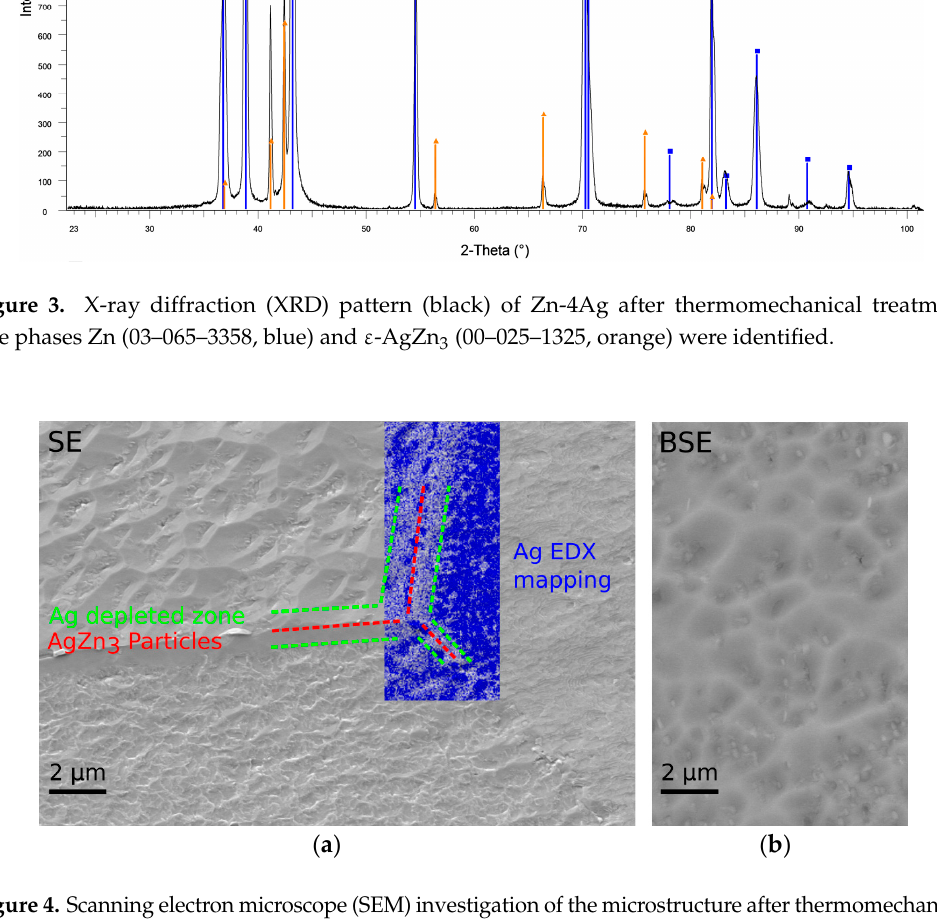
Figure 5. Corrosion rates of pure Zn and Zn-4Ag in DMEM and McCoy’s 5A calculated from released Zn ions.